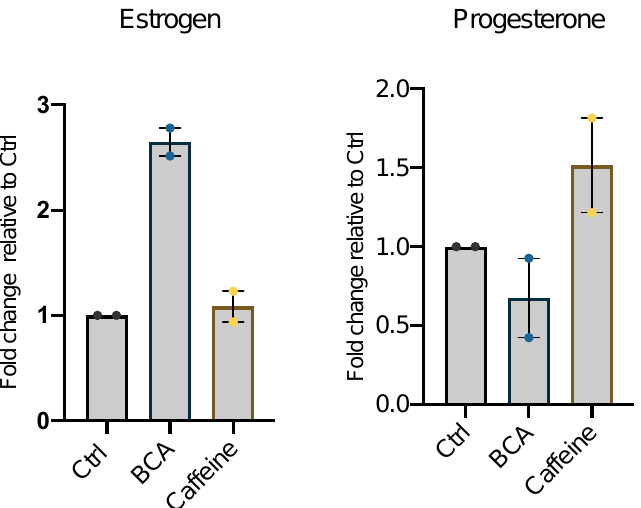
Figure 6. Lipid droplets analysis. Morphological characteristics of lipid droplets in cultured hGL5 cells. ( A ) Untreated samples. ( B ) 24 h, BCA-treated cells. ( C ) Caffeine-treated cells. Magnification: 400×. ( D ) Lipid content quantification by Oil red O extraction. *** Ctrl vs. Caffein and BCA vs. Caffein: significance p < 0.0001.